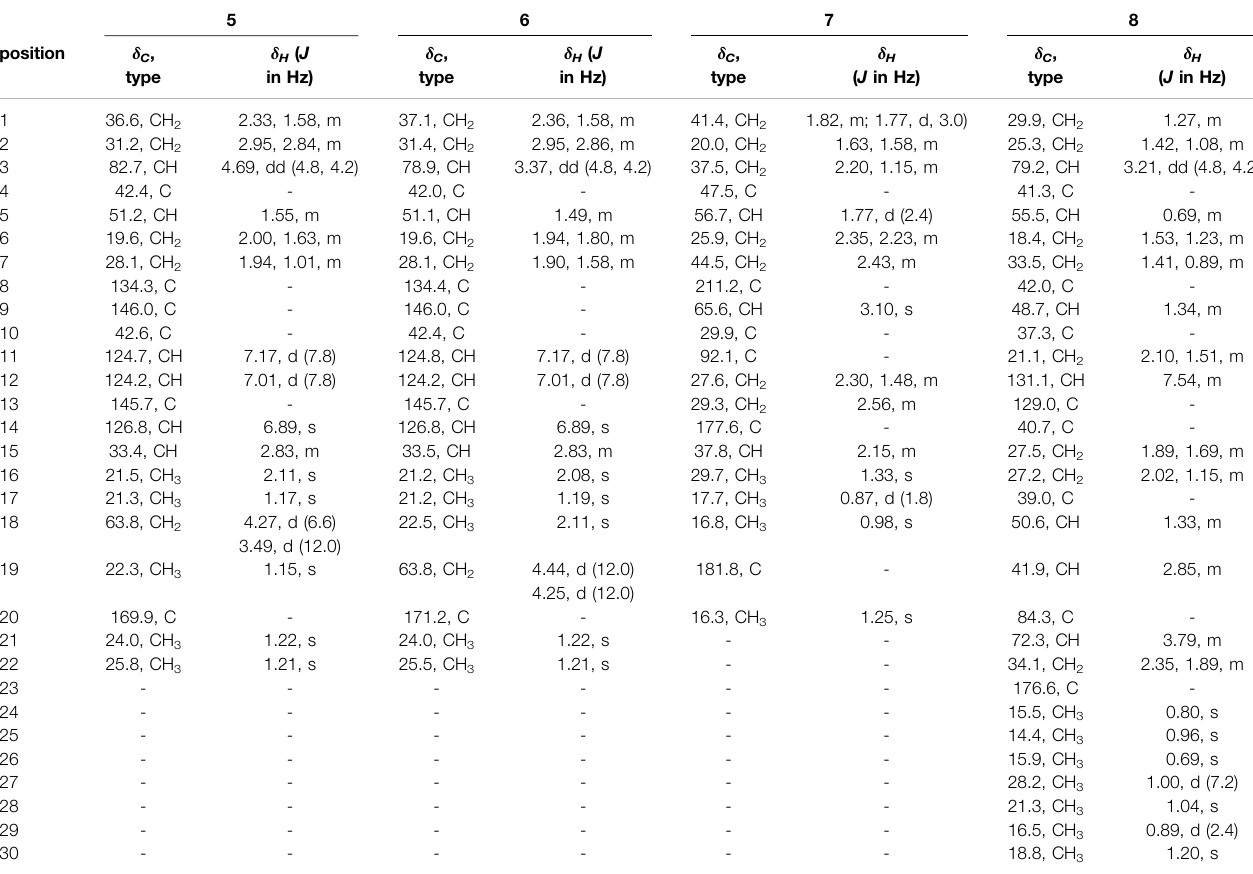
TABLE 2 | NMR spectroscopic data for compounds 5 – 8 (600 MHz for 1 H NMR and 150 MHz for 13 C